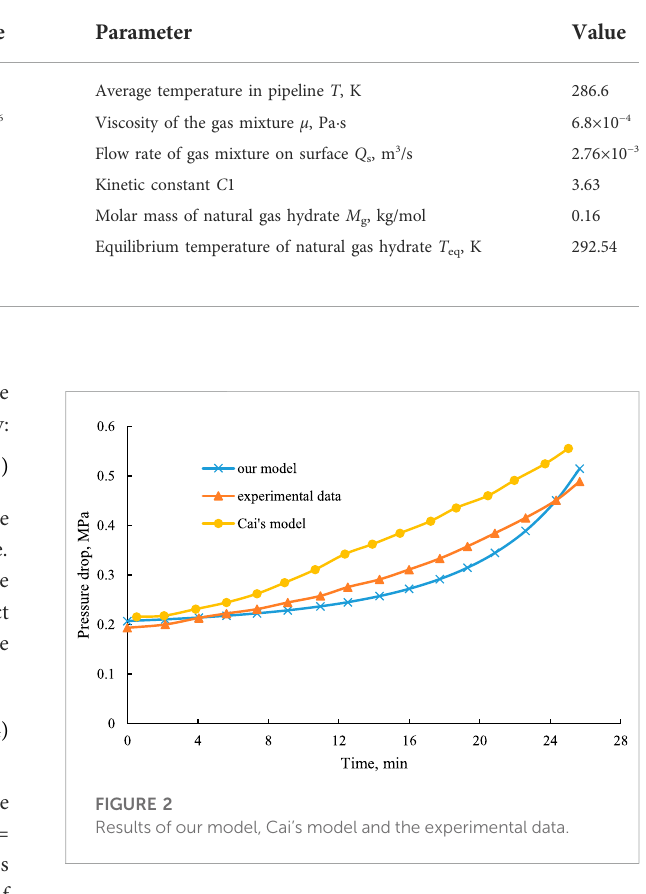
TABLE 1 Data of the parameters for model veri fi cation.